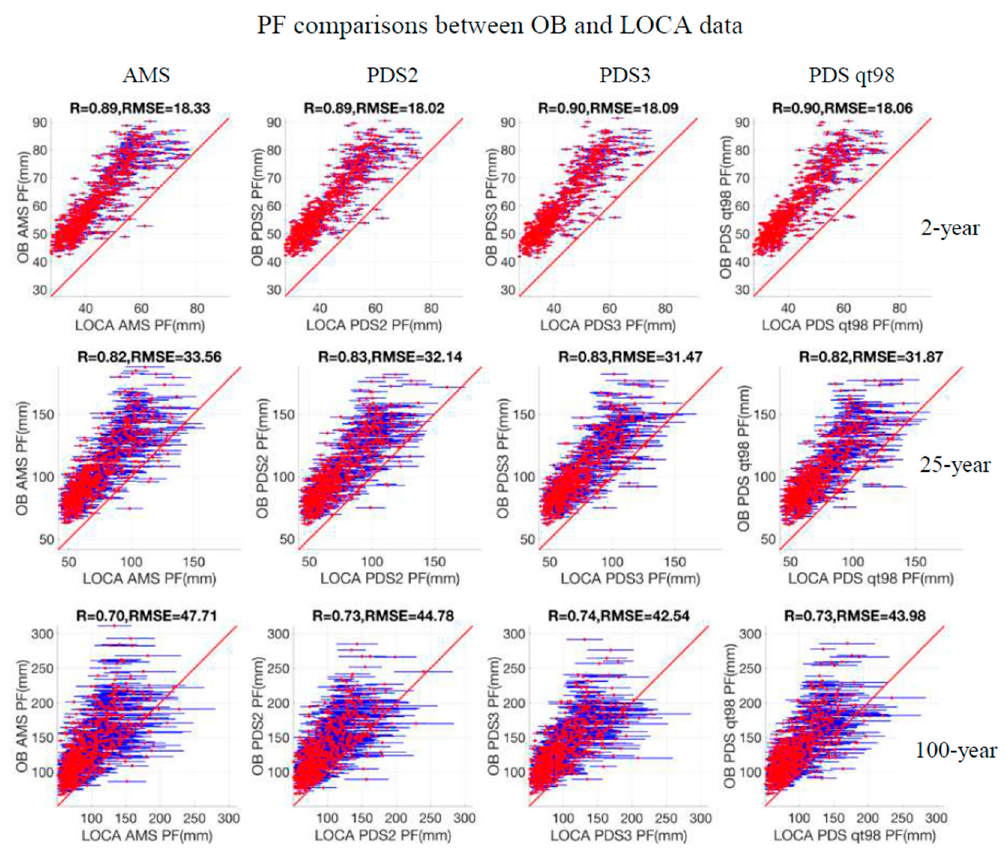
Figure 5. Similar to Figure 4 but for the LOCA data.